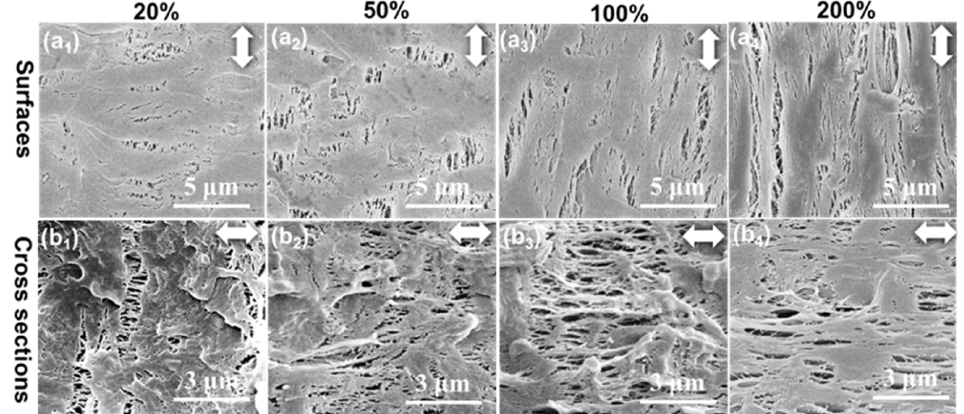
Figure 4. SEM images of the ( a1 – a4 ) surface and ( b1 – b4 ) cross-section microporous structure of β -PP films during longitudinal stretching. The tensile temperature was 100 °C and the tensile strains were ( a1 , b1 ) 20%, ( a2 , b2 ) 50%, ( a3 , b3 ) 100%, and ( a4 , b4 ) 200%. The white double arrow represents the direction of stretching.